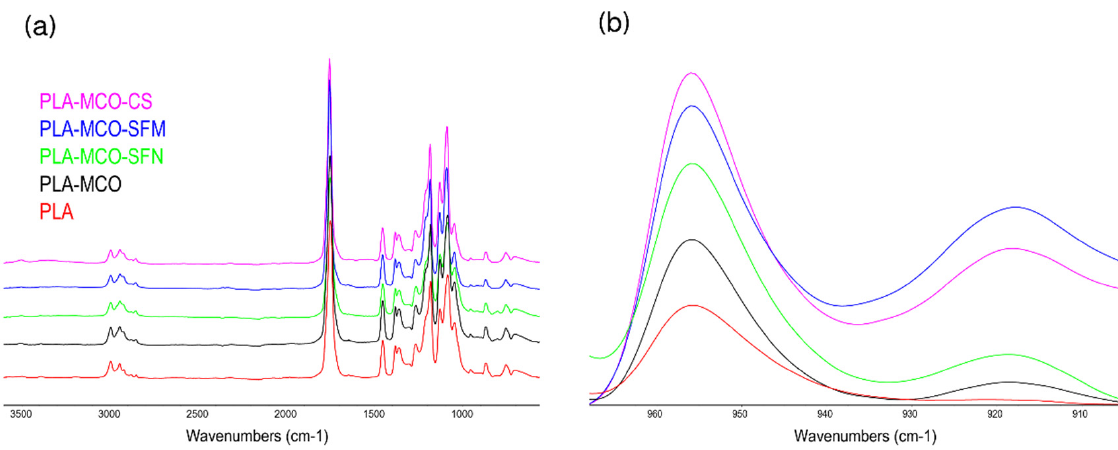
Figure 6. ATR-FTIR spectra of the Silk-MCO-PLA composites. ( a ) Full spectra of the composites. ( b ) Selected region of the spectra used to measure the relative crystallinity of PLA.